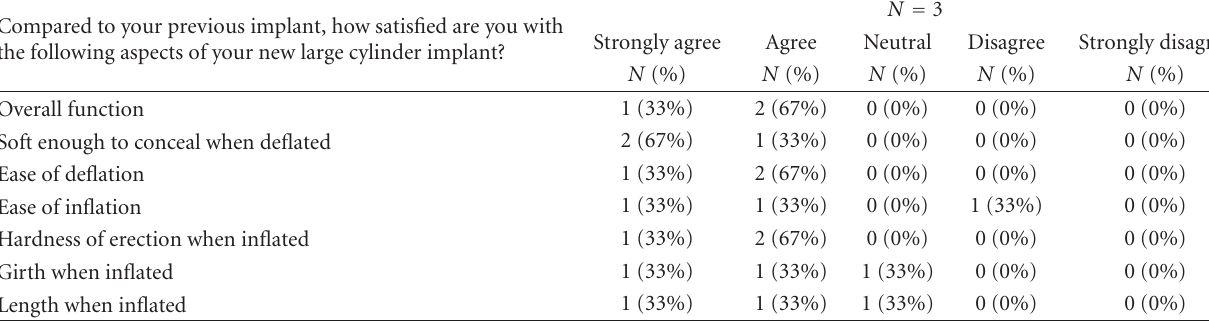
Table 7: Satisfaction of revision